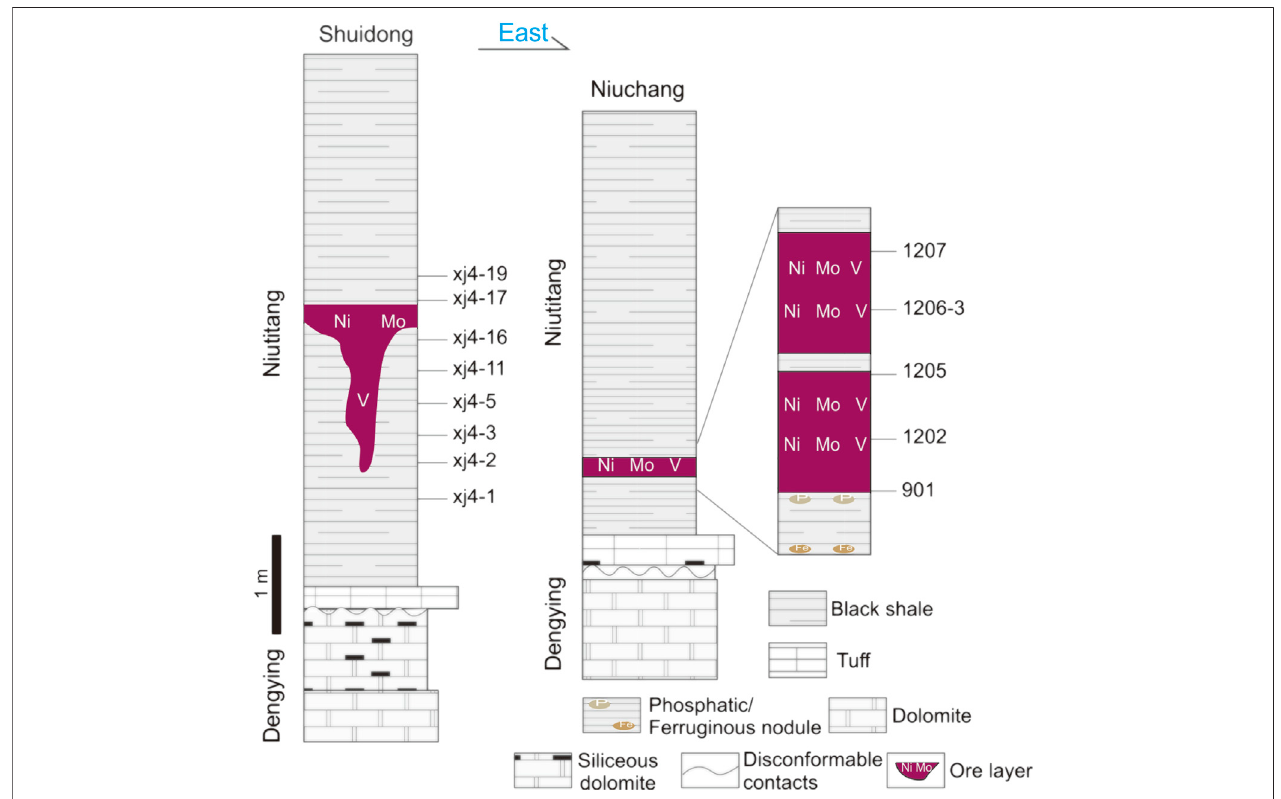
FIGURE 2 | Lithological column and sampling locations in the studied sections at Shuidong and Niuchang, Guizhou Province.